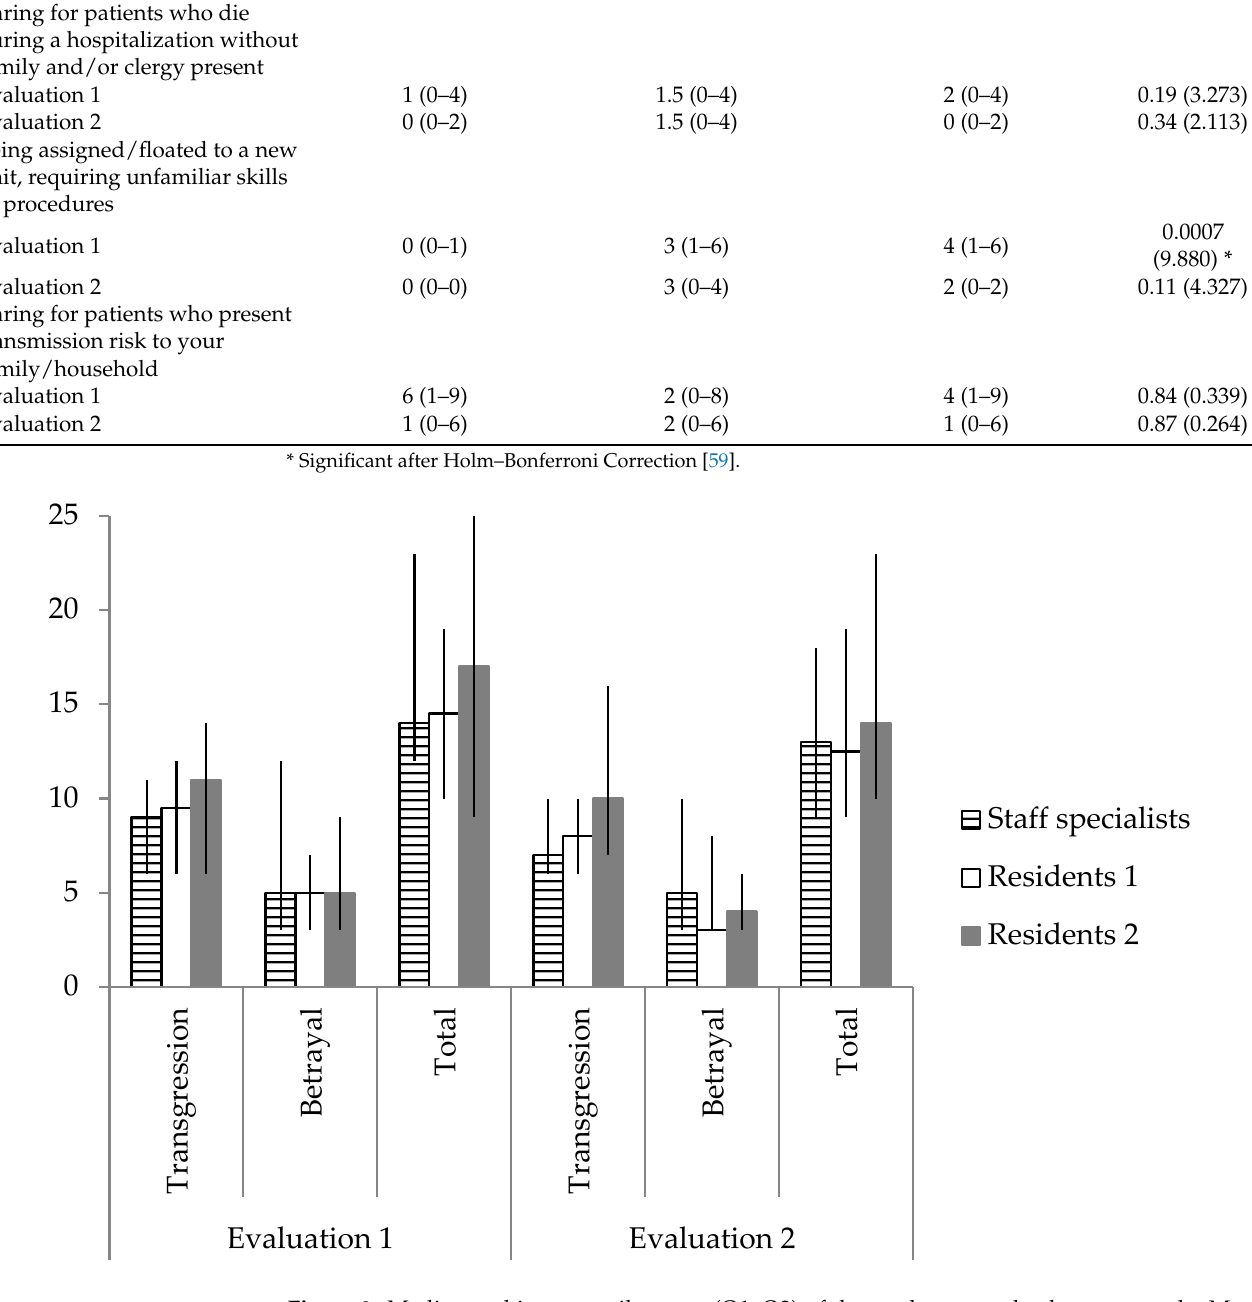
Table 3. Summary of responses to the moral distress items on COVID-19 situations of 108 physi- cians according to the experience group during the two evaluations. Comparisons among groups were performed by Kruskal Wallis ANOVA.